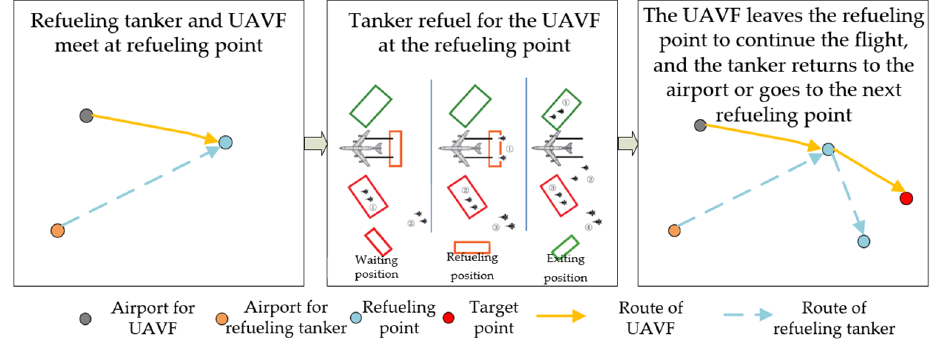
Figure 2. Refueling process of UAVF.